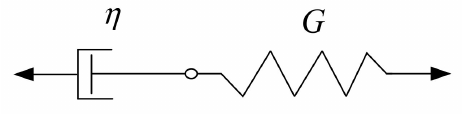
Figure 1. Maxwell